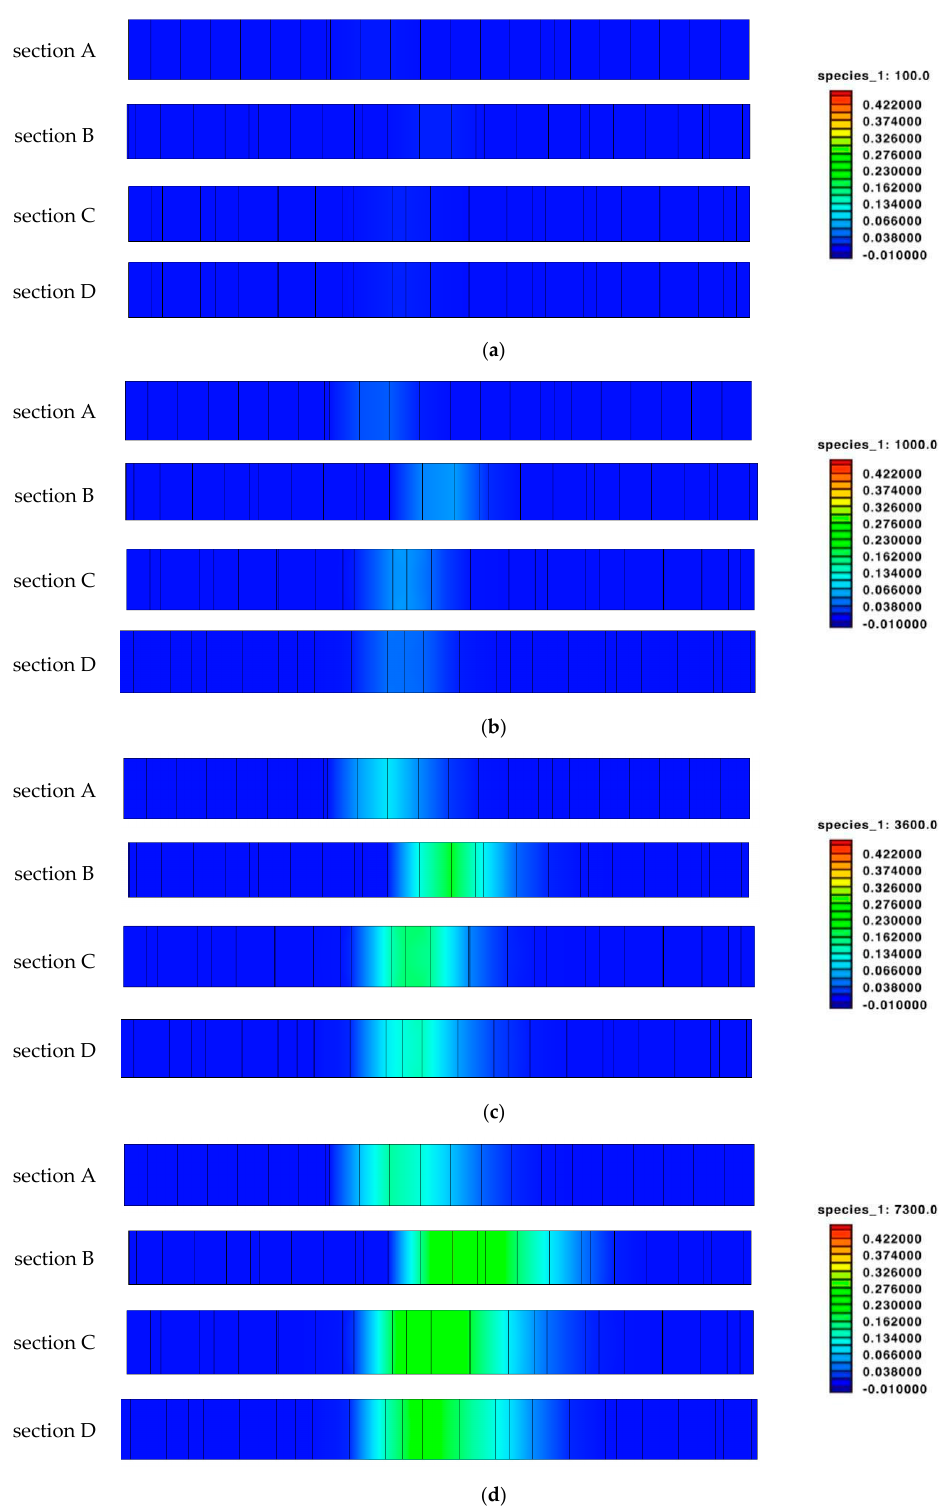
Figure 13. Simulation results of migration of the ammonia pollution plume in the four sections. ( a ) Simulation results of plane migration of ammonia pollution ( b ) Simulation results of plane migration of ammonia pollution ( c ) Simulation results of plane migration of ammonia pollution ( d ) Simulation results of plane migration of ammonia